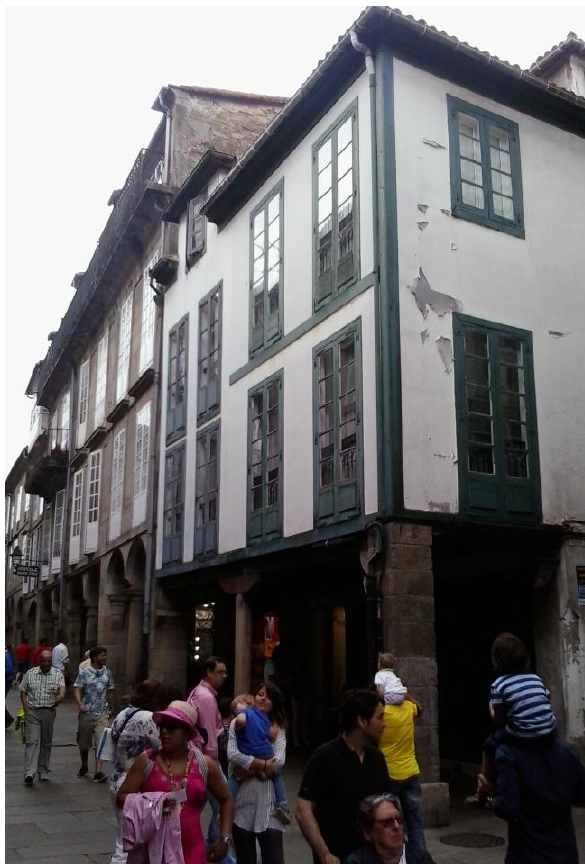
Figure 12. Houses with arcades in the Rúa Nova in Santiago de Compostela. An example of how the half timber typology evolved, conserving the arcade but increasing the façade openings and adding a floor. Source: A.F.P.